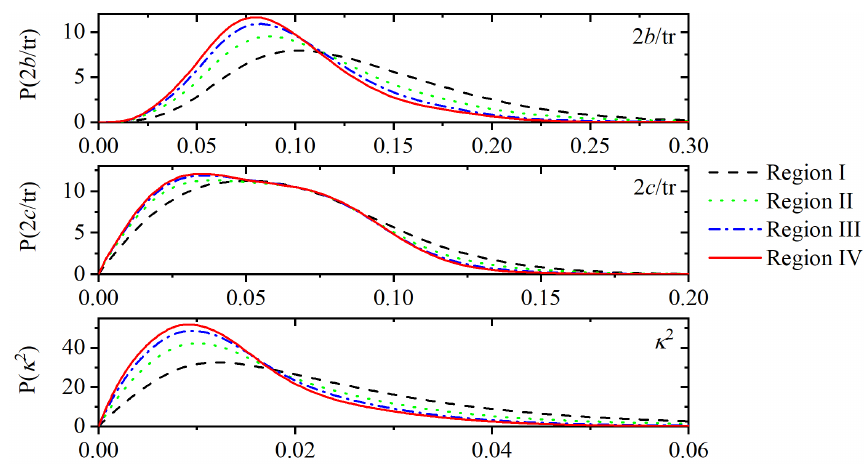
Figure A4. Probability distributions of shape descriptors b , c , and κ 2 for Regions I and IV. The first two are made dimensionless by dividing by half the trace of G